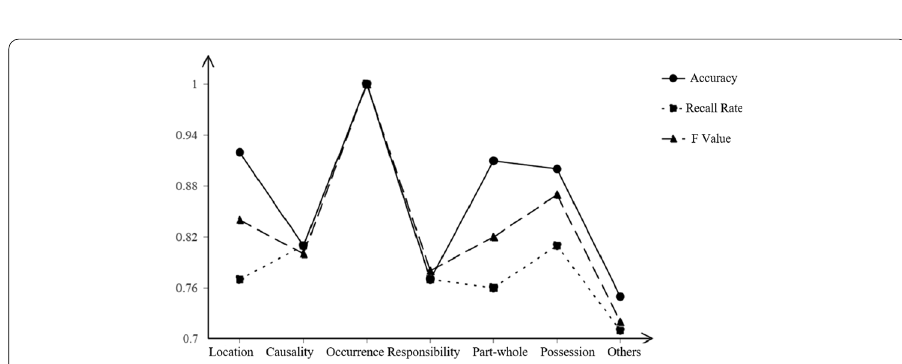
Fig. 7 Comparison on average accuracy, recall and F